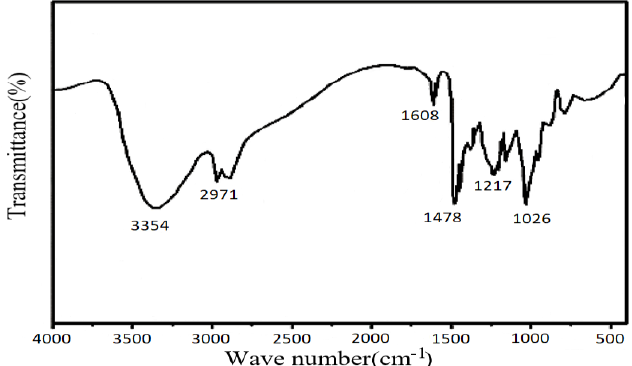
Figure 8. FTIR profiles recorded for the crosslinker.